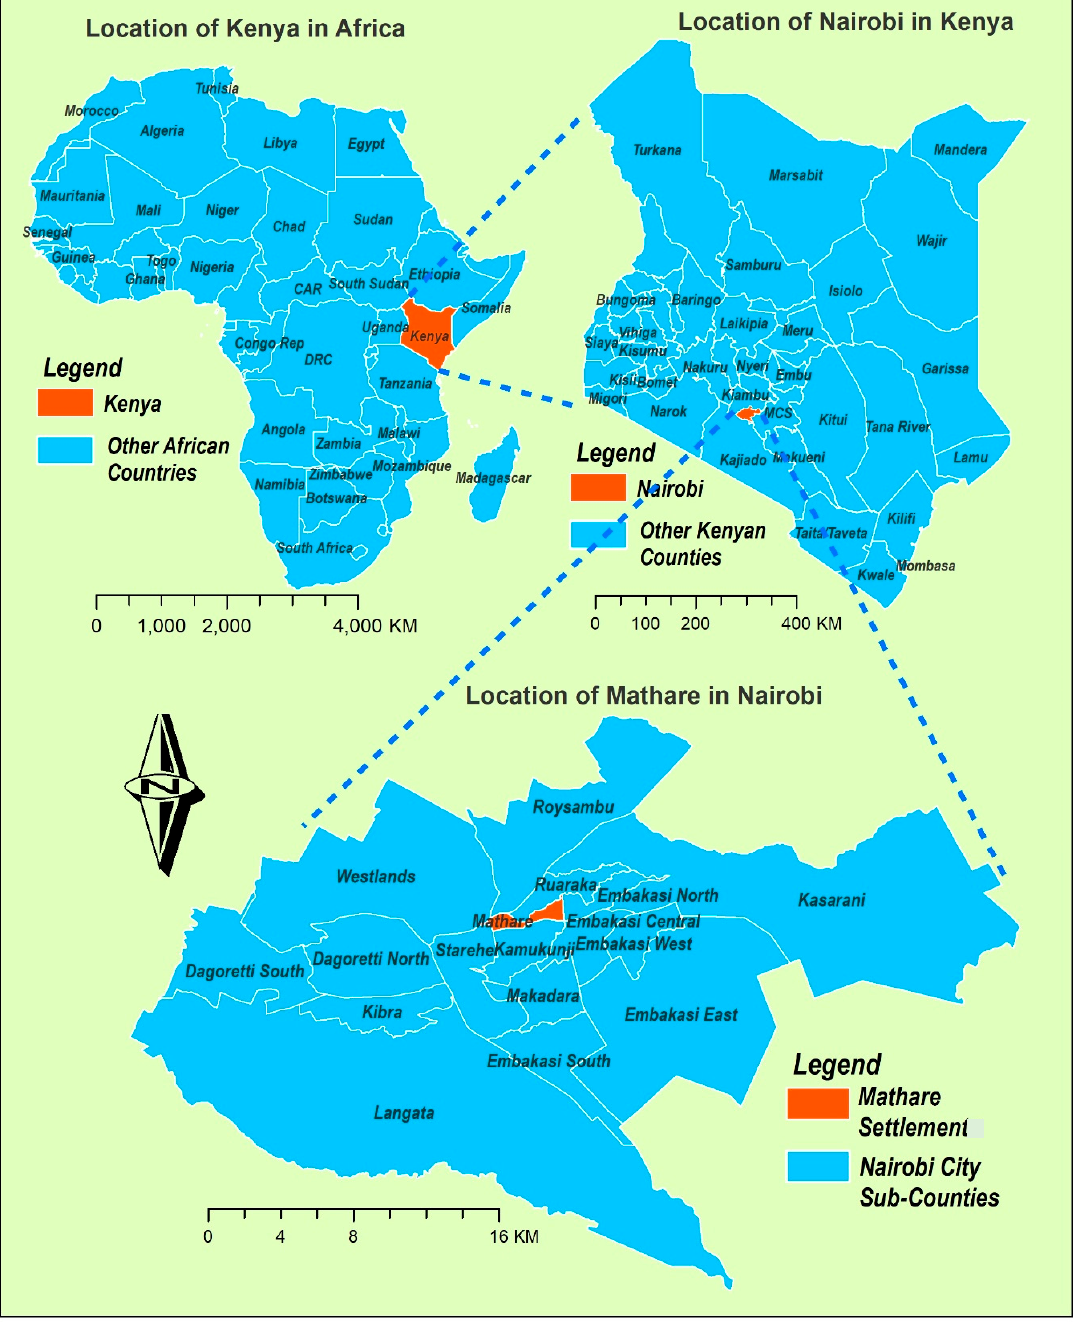
Figure 1. Location of Mathare informal settlement in the context of Africa (Source: authors).